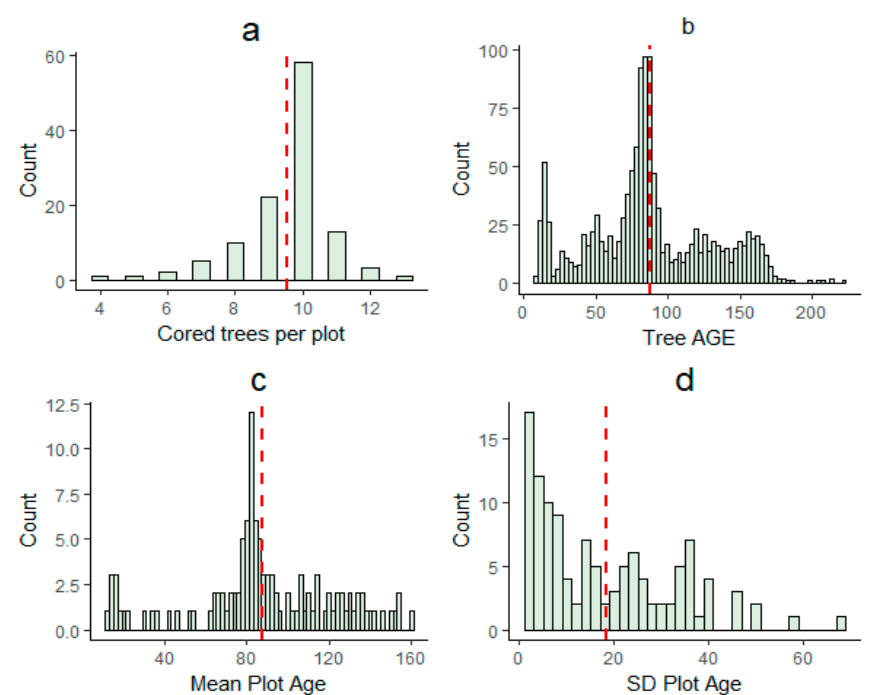
Figure 3. Distribution for final age dataset with mean indicated by red dashed line, ( a ) the number of trees available per plot n = 116; ( b ) age distribution of all trees independent of plot n = 1277; ( c ) mean plot age n = 116; ( d ) standard deviation of plot age n = 116.